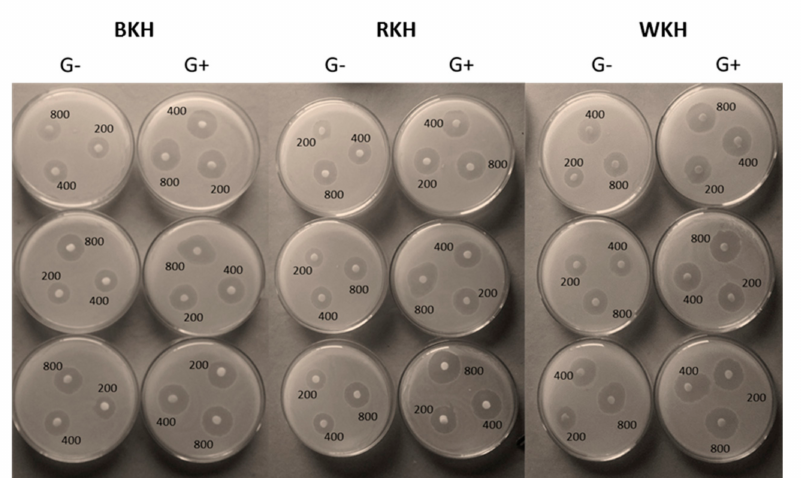
Figure 4. The antibacterial activity of black, red, and white kidney bean protein hydrolysate (BKH, RKH, and WKH) obtained by 30 min Alcalase hydrolysis against pathogenic G+, and G-